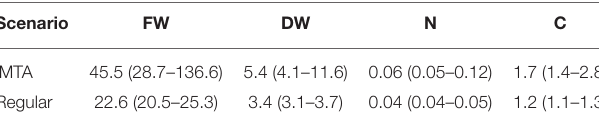
TABLE 1 | Saccharina latissima fresh weight (FW) and dry weight (DW) yields and nitrogen (N) and carbon (C)-uptake with and without IMTA. Scenario